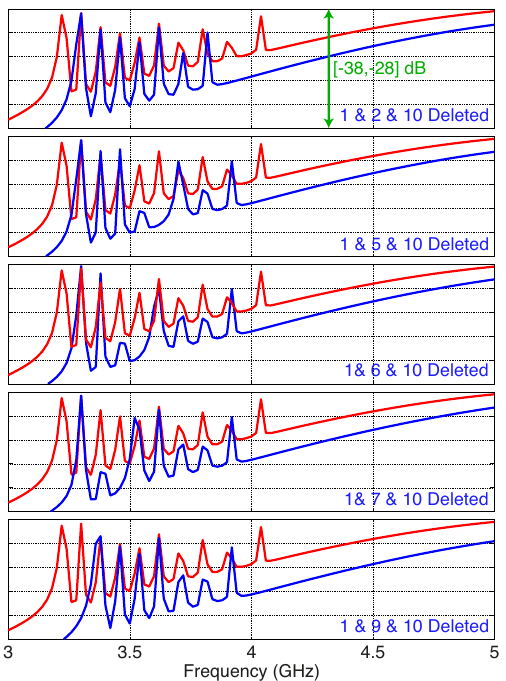
Figure 4: Electromagnetic responses of RFID tags that are obtained by deleting three bits from the overall structure in Fig. 1. The largest resonator is always